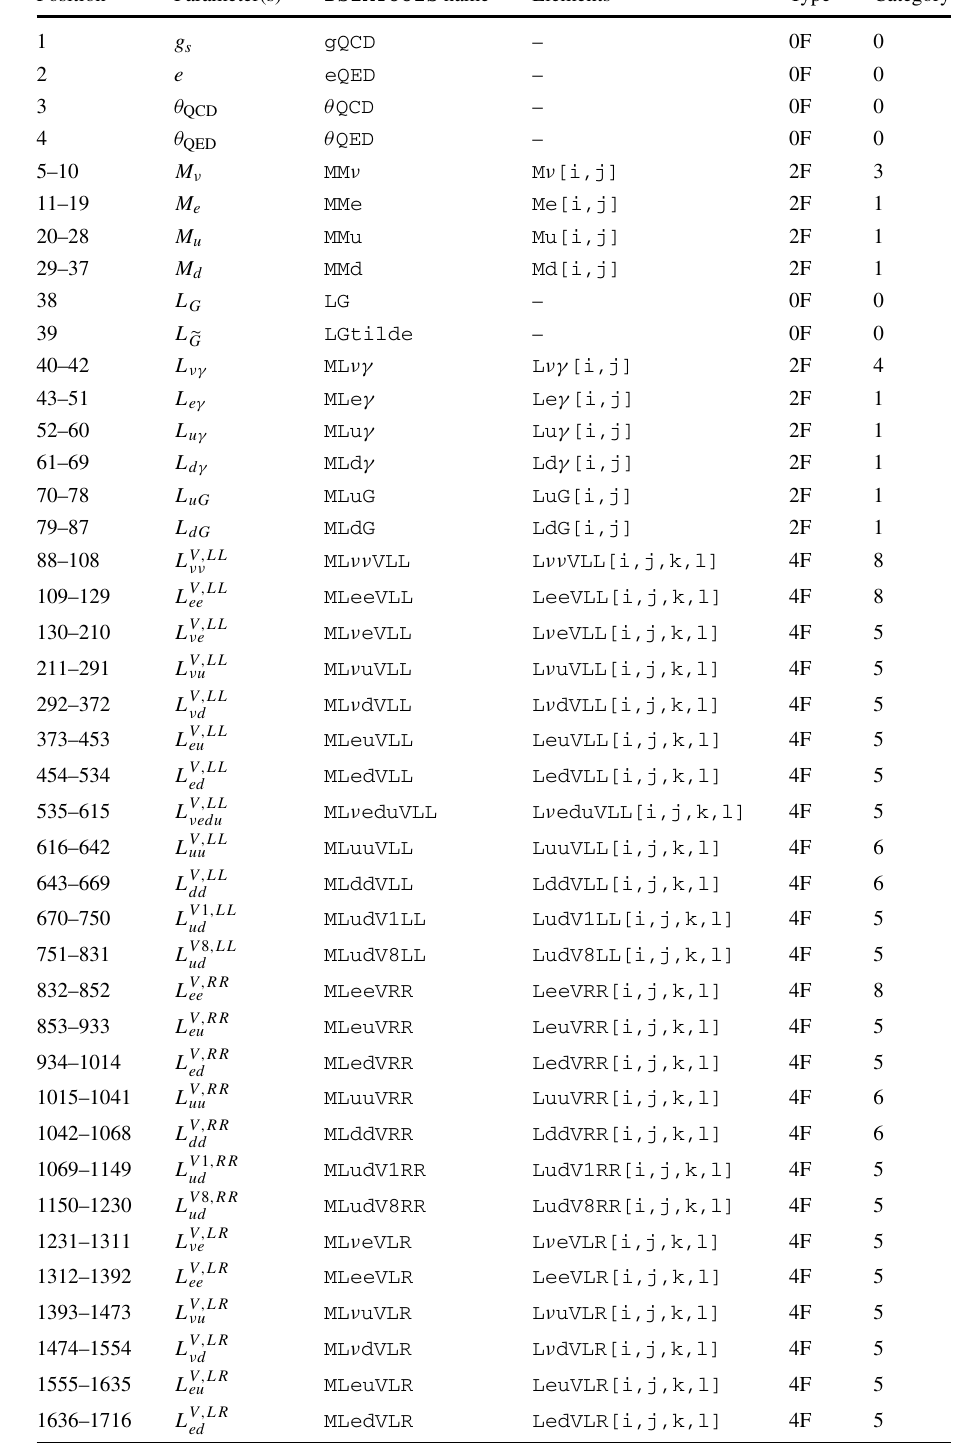
Table 18 LEFT parameters. Position denotes the position of the parameter (or parameters for 2- and 4-fermion objects) in the LEFTParametersTotal global array. Type indicates the type of parameter (with nF standing for n-fermion) and Category denotes the index symmetry category of the coefficient, being relevant for 2- and 4-fermion